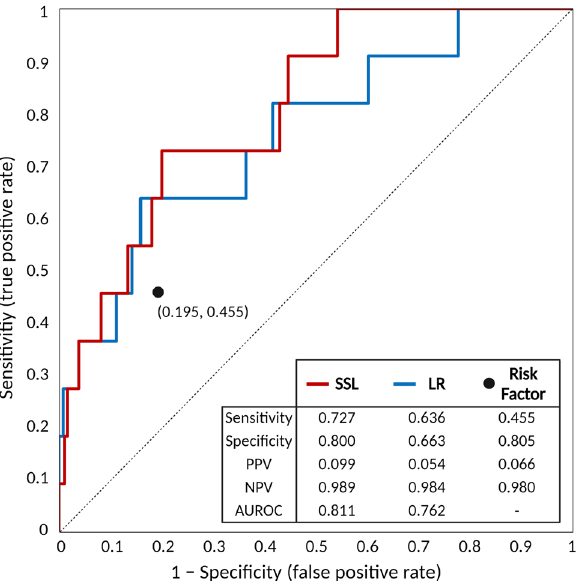
Figure 1. Receiver operating characteristic curve of proposed prediction model with graph-based semi- supervised learning in test set population (enrolled 2018–2019). Risk factors: conventional risk factors recommended by American College of Obstetricians and